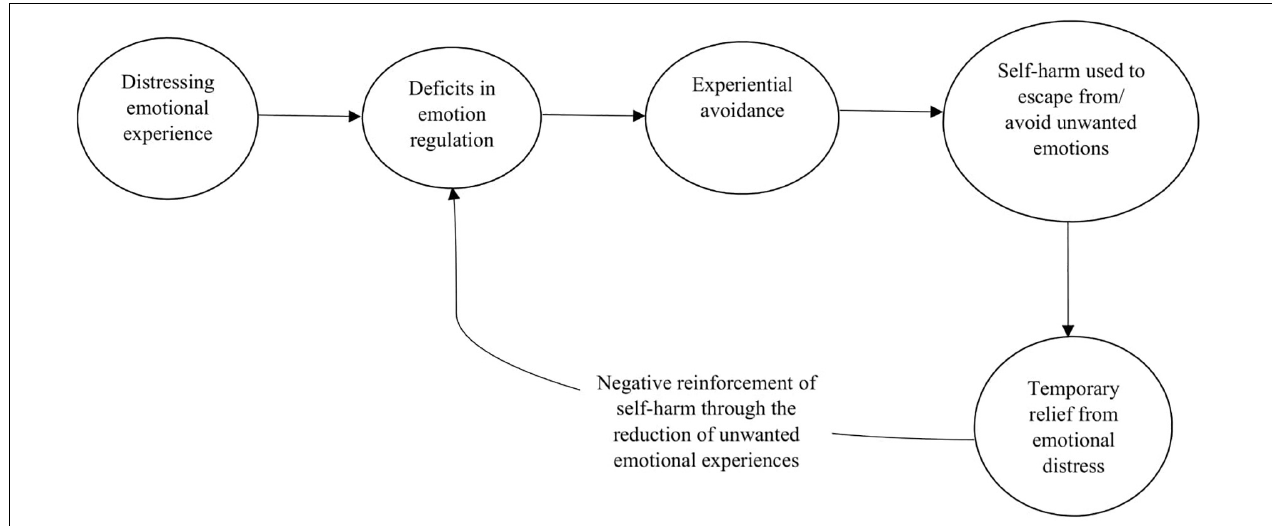
FIGURE 1 | Experiential avoidance theory of self-harm. This figure provides a simplified illustration of the experiential avoidance theory of self-harm. As highlighted, deficits in emotional regulation may contribute to an individual using experiential avoidance as a response to distressing emotional experiences. Here, experiential avoidance refers to attempts to avoid distressing emotions, even when such attempts may cause harm to the individual. According to the theory, the individual may use self-harm as an experiential avoidance strategy to escape from or avoid their unwanted emotions. Self-harm may provide the individual with temporary relief from their emotional distress, thus leading to negative reinforcement of their self-harm. This negative reinforcement feeds back into the person’s emotional regulation deficits, thus repeating the cycle of experimental avoidance and maintaining the use of